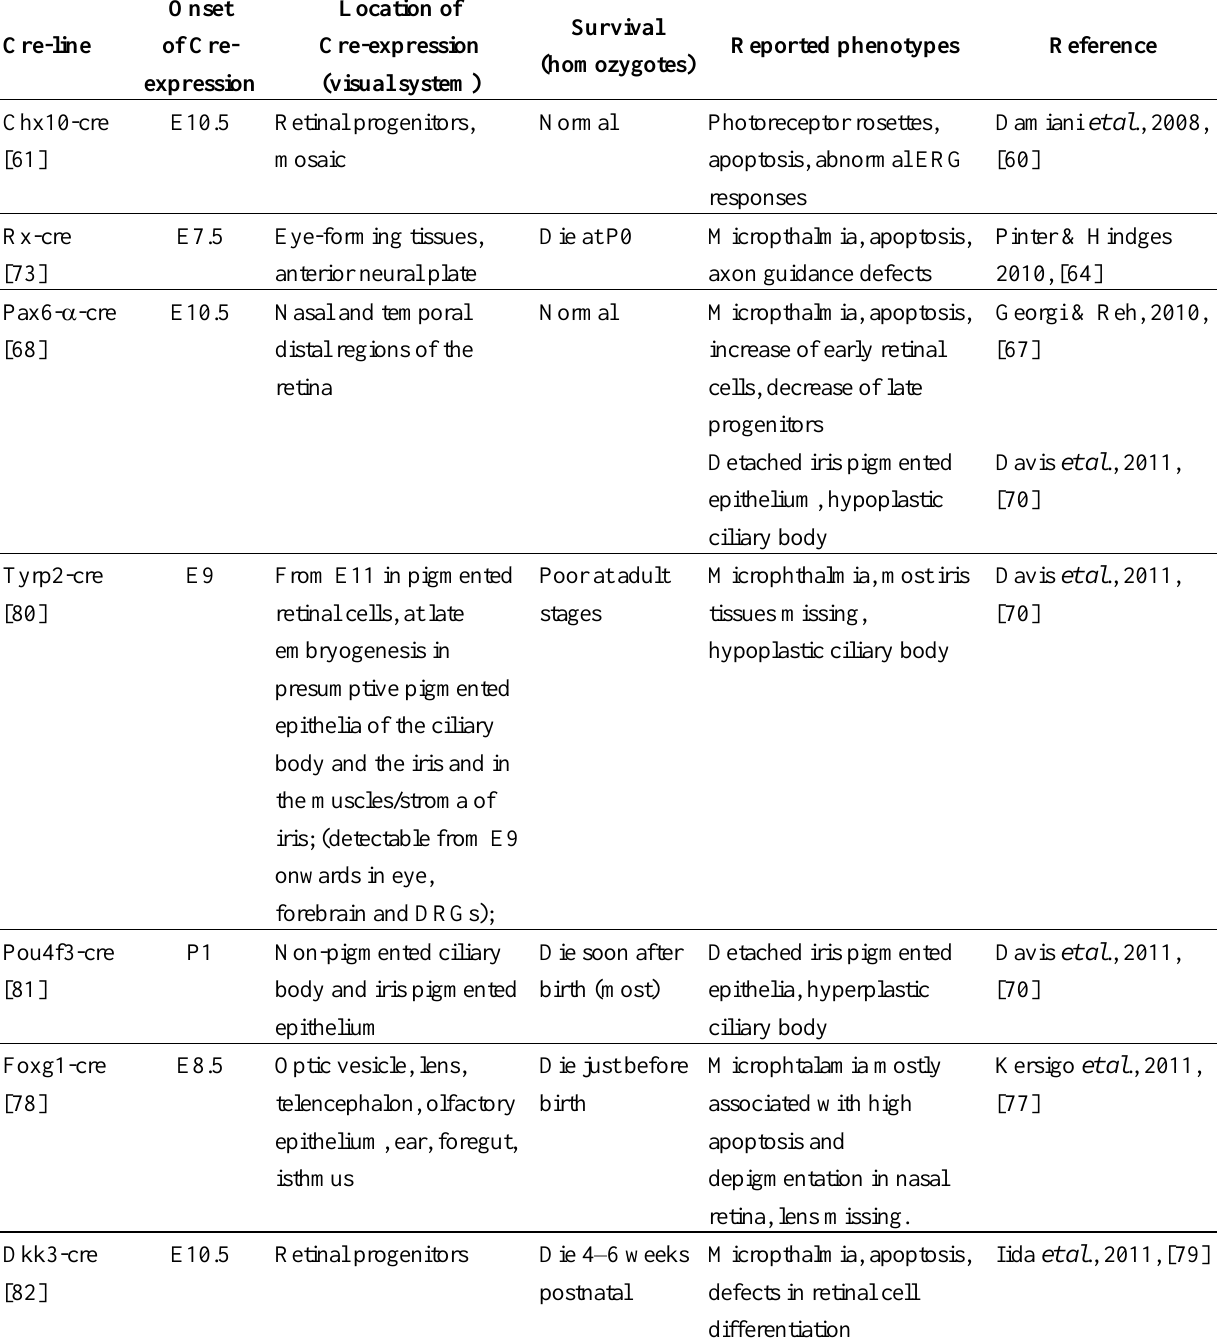
Table 1. Conditional Dicer deletion studies in the mouse visual